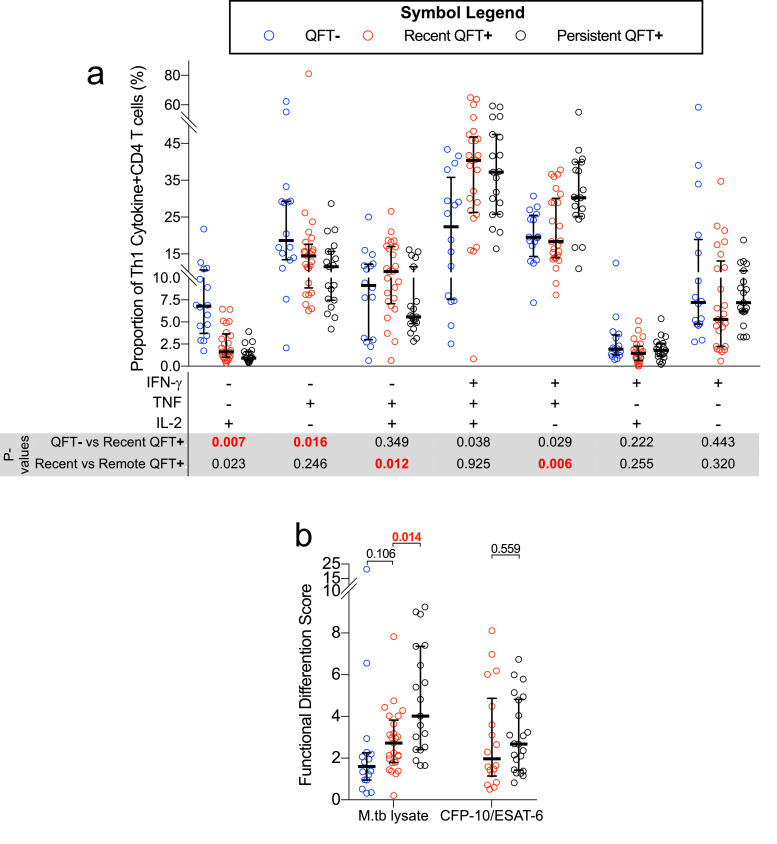
Recent QFT+ is associated with lower proportions of M.tb lysate-specific functionally differentiated CD4 T cell subsets than persistent QFT+. (a) Proportions of M.tb lysate-specific Th1 polyfunctional profiles detected before (QFT−, n= 16), after (recent QFT+, n=25) and during persistent M.tb infection (persistent QFT+, n=22) in responders only. (b) Functional differentiation scores of M.tb-specific CD4 T cells before (QFT−, M.tb lysate, n= 16), after (recent QFT+, CFP-10/ESAT-6, n= 18; M.tb lysate, n=25), and during persistent M.tb infection (black symbols, CFP-10/ESAT-6, n= 22; M.tb lysate, n=19) in responders only. P-values were calculated using the Wilcoxon-signed rank test for paired (QFT− versus recent QFT+) or the Mann–Whitney U test for unpaired (recent versus persistent QFT+) comparisons and corrected for multiple comparison using the Benjamini–Hochberg method with a false discovery rate (FDR) of 0.05. P-values highlighted in red, bold text were considered significant.